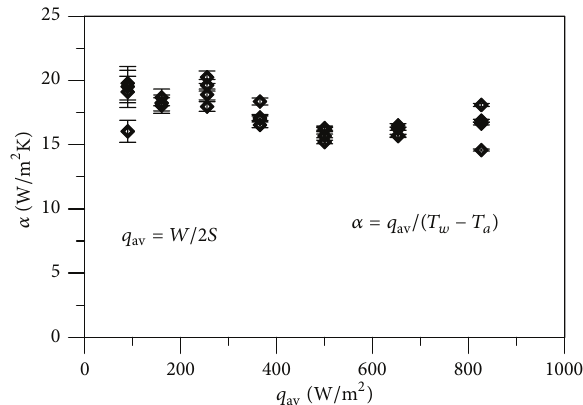
Figure 2: The measured heat transfer coefficient for different heat flux densities. 𝑆 : area of one side of the foil, 𝑊 : power of electric heating of the foil, 𝑇 𝑤 : average measured temperature of the foil surface, and 𝑇 𝑎 : temperature of ambient